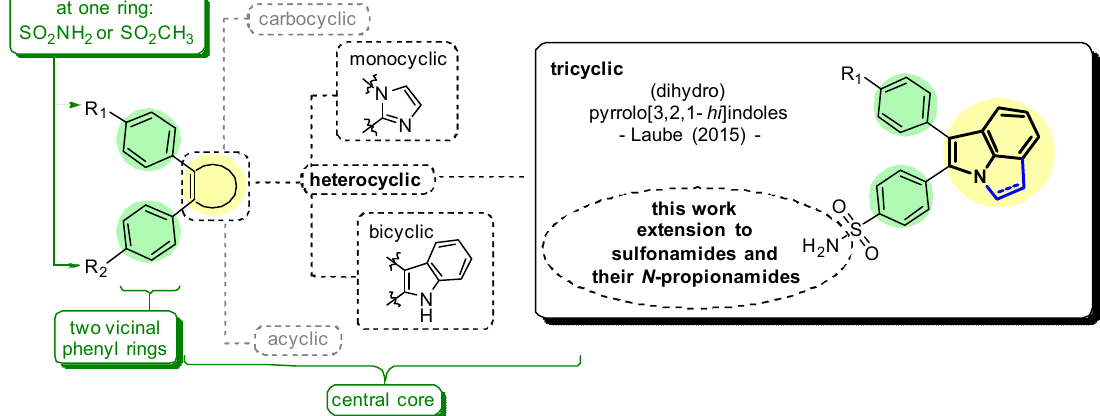
Figure 1. General structure of cyclooxygenase-2 (COX-2) inhibitors and target compounds of this work.